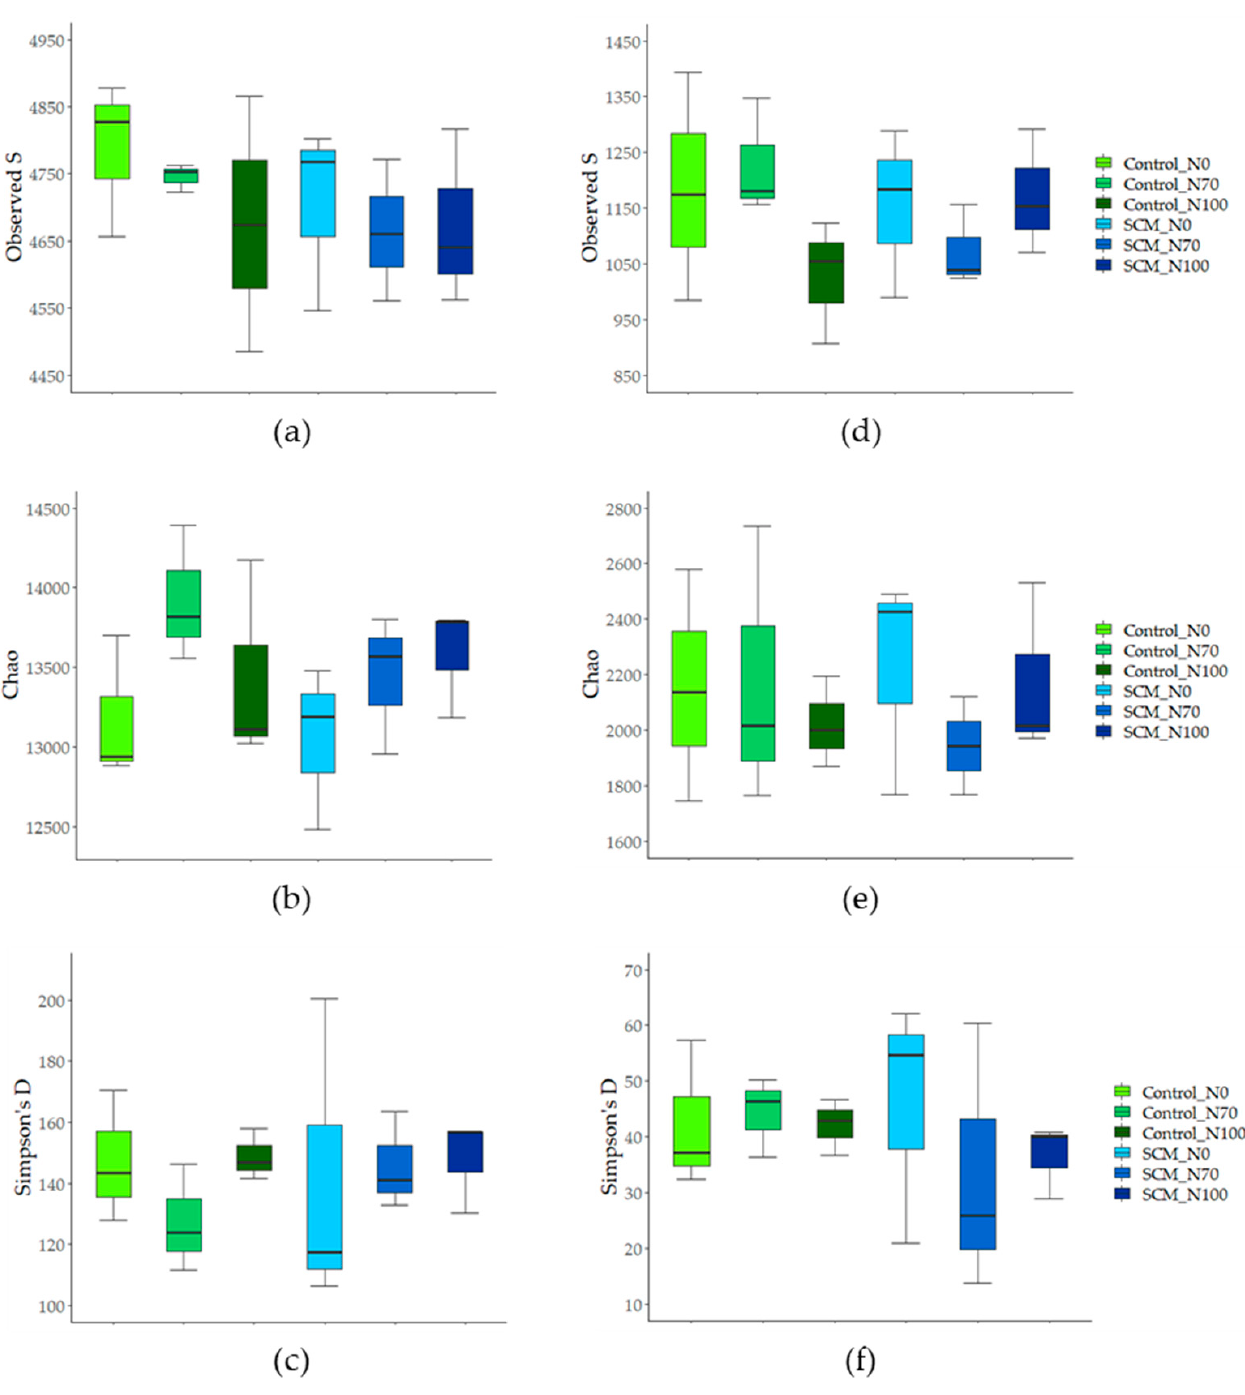
Figure 2. Estimation of α -diversity indexes and richness of each field separately for bacteria ( a – c ) and fungi ( d – f ). Control_N0 = Control with 0% N-fertilization; Control_N70 = Control with 70% N-fertilization; Control_N100 = Control with 100% N-fertilization; SCM_N0 = SCM with 0% N-fertilization; SCM_N70 = SCM with 70% N-fertilization; SCM_ N100 = SCM with 100% N-fertilization.